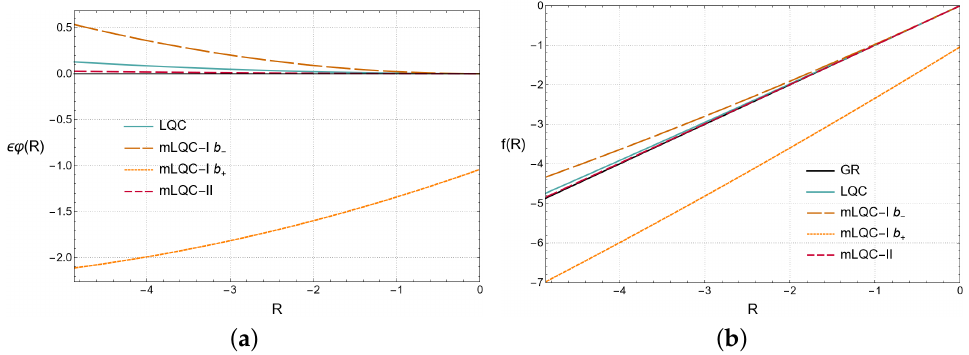
Figure 4. The plot ( a ) (Deviation, from GR, of the effective Lagrangian: a comparison between all models) contains Equation (35), for LQC (solid blue line), Equation (41), for the b − branch of mLQC-I (dashed dark orange line), Equation (51), for the b + branch of mLQC-I (dashed light orange line) and Equation (58), for mLQC-II (dashed pink line), with c 1 = c 2 = 0, for − 2 κρ I c ≤ R ≤ 0. The plot ( b ) (Effective f ( R ) function: a comparison between all models) presents the effective f ( R ) functions for all models, including GR (solid black line), with Λ = 0. These are Equation (36), for LQC (solid blue line), Equation (45), for the b − branch of mLQC-I (dashed dark orange line), Equation (53), for b + branch of mLQC-I (dashed light orange line) and Equation (60), for mLQC-II (dashed pink line), for − 2 κρ I ≤ R ≤ c